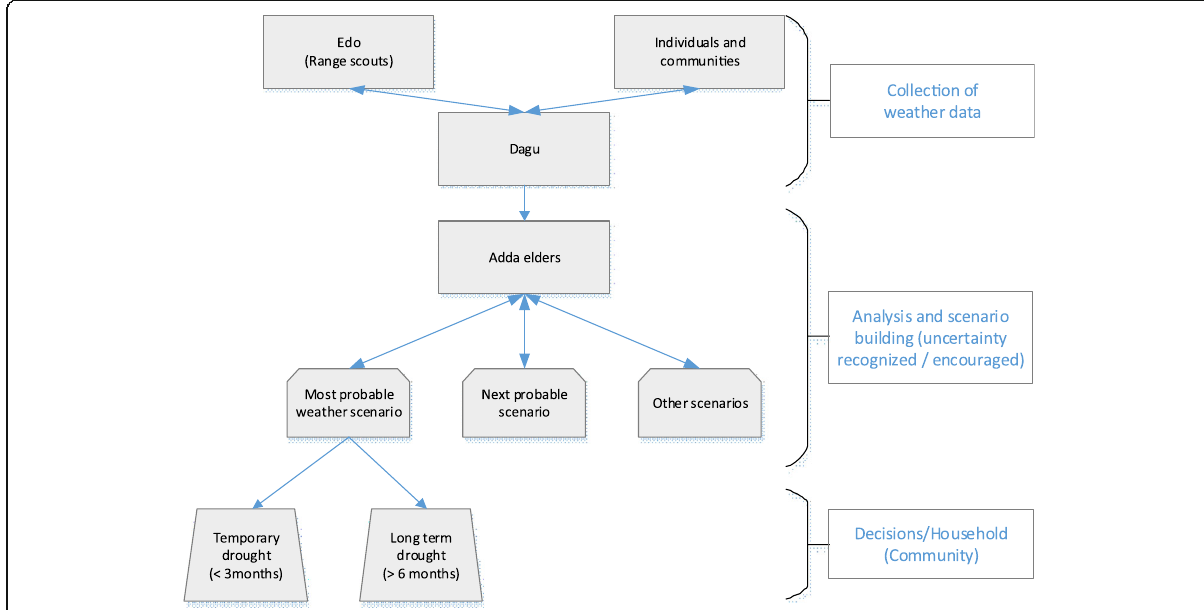
Fig. 3 Collection, interpretation (analysis) and decision-making based on tradition weather forecasting information in the Afar pastoral areas (line arrows indicate the flow of information; solid arrows indicate interpretation or